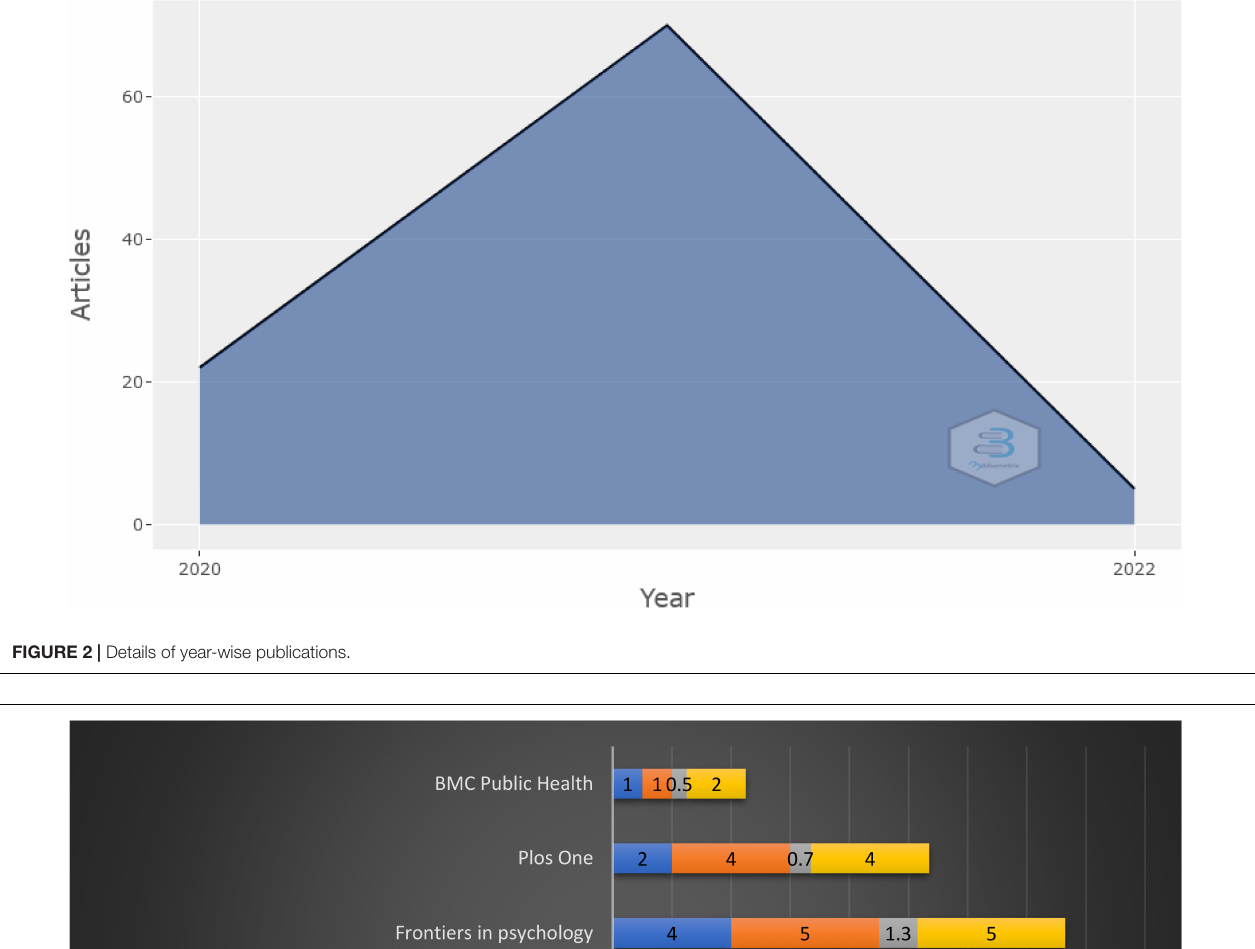
FIGURE 2 | Details of year-wise publications.